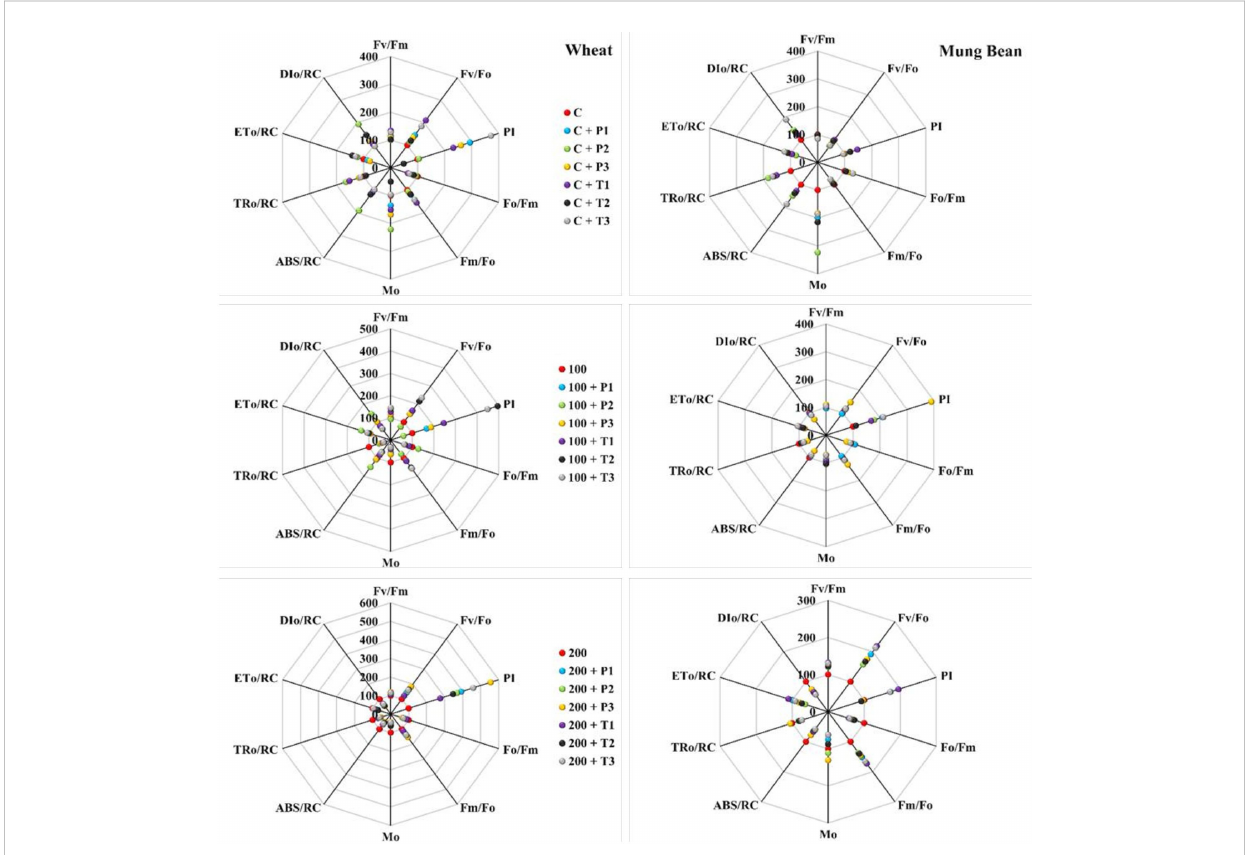
FIGURE 7 Effects of bio-priming on maximum quantum yield of PSII ( FV/FM ), activity of water splitting complex on donor site of PSII ( FV/F O ), performance index (PI), quantum yield of energy dissipation ( F O /FM ), electron transport rate through PSII ( FM/F O ), approximated initial slope of fl uorescence transient ( M O ), absorption per reaction centre ( ABS/RC ), trapping per reaction centre ( TR O /RC ), electron transport per reaction centre ( ET O /RC ) and dissipation per reaction centre ( DI O /RC ) of wheat and Mung bean grown under saline environment. The values of the parameters are expressed as percentage increase or decrease over the control (considered as 100). The symbols on the horizontal axis represents: Control: Seeds without priming, Pl = Seed priming with Paecilomyces lilacinus, Th= Seed priming with Trichoderma hamatum 5, 10, 15 = duration of bio-priming in minute, 0, 100 & 200 mM NaCl concentration. On bars, vertical lines represent ± Mean Standard Error (S.E) and similar alphabets represents non-signi fi cant difference between the means of treatment at p<0.05